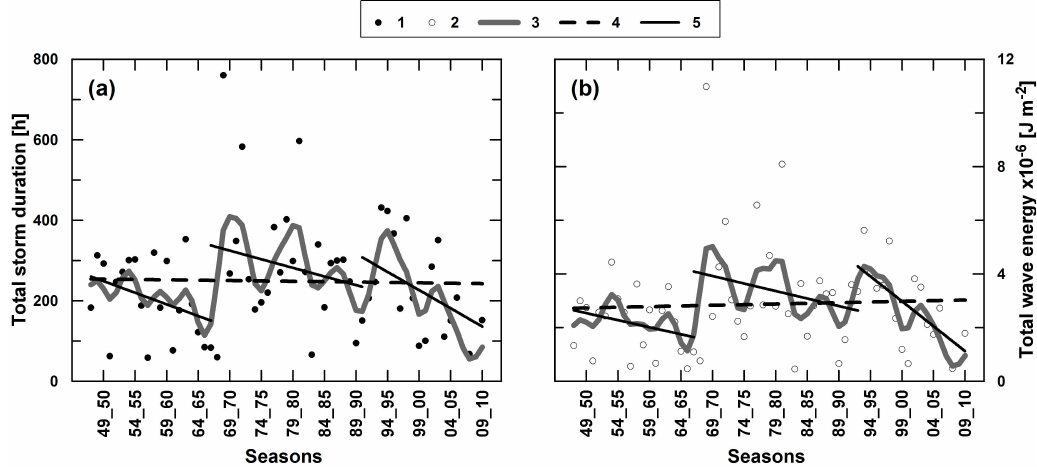
Fig. 6. Variability of the total storm duration and wave energy during 1948–2010; (a) Total storm duration: 1 – data points, 3 – LPF approximation, 4 – global linear trend ( − 1.9hdecade − 1 , R 2 = 0 . 0006), 5–local downward linear trends (I sub-period – 57.8hdecade − 1 , R 2 = 0 . 12; II sub-period – 42.8hdecade − 1 , R 2 = 0.035; III sub-period – 90.4hdecade − 1 , R 2 = 0 . 18); (b) Total wave energy: 2 – data points, 3 – LPF approximation, 4 – global linear trend (0.05 × 10 − 6 Jm − 2 decade − 1 , R 2 = 0 . 18), 5-local downward linear trends